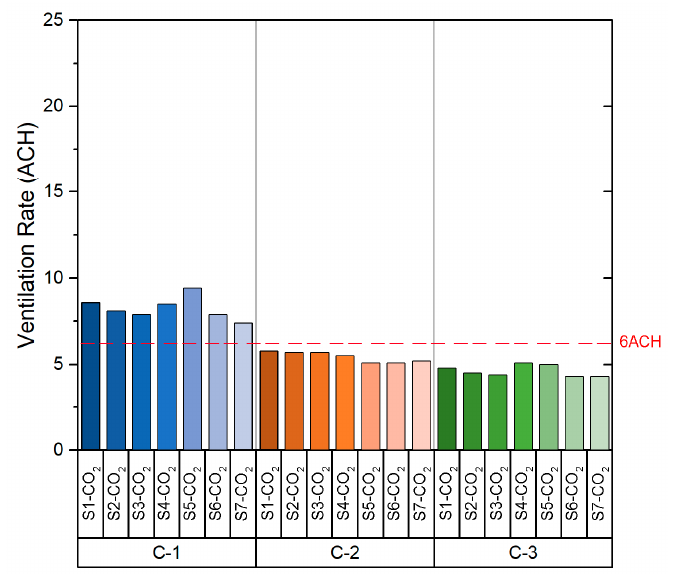
Figure 4. Ventilation rate (ACH) in Classroom B1-A1.